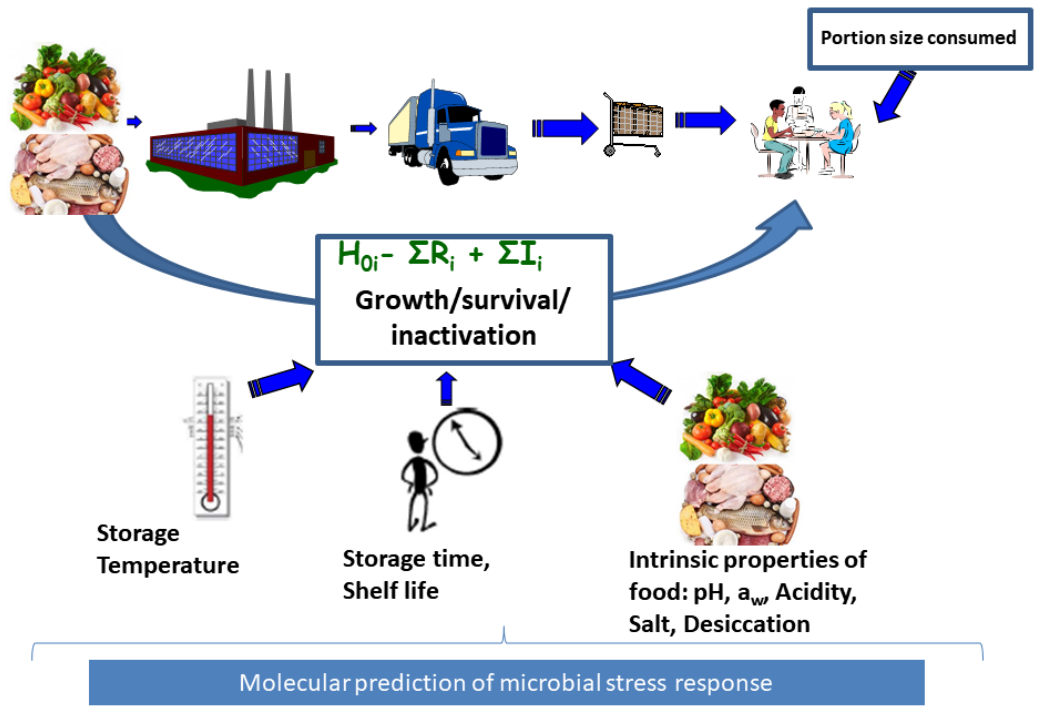
Figure 1. Food chain exposure assessment. This involves input data consisting of food consumption data and microbial growth data together with associated food inherent, environmental and process induced factors influencing microbial growth ( I ) or reduction ( R ) in any of the stages of the food chain including processing, distribution, retail and consumer level. The final concentration at exposure consists of initial contamination ( Ho ) plus the total increase ( ∑ I ) , minus total reduction ( ∑ R ) . Use of molecular data will support exposure assessment for strain or microbial population subgroup i